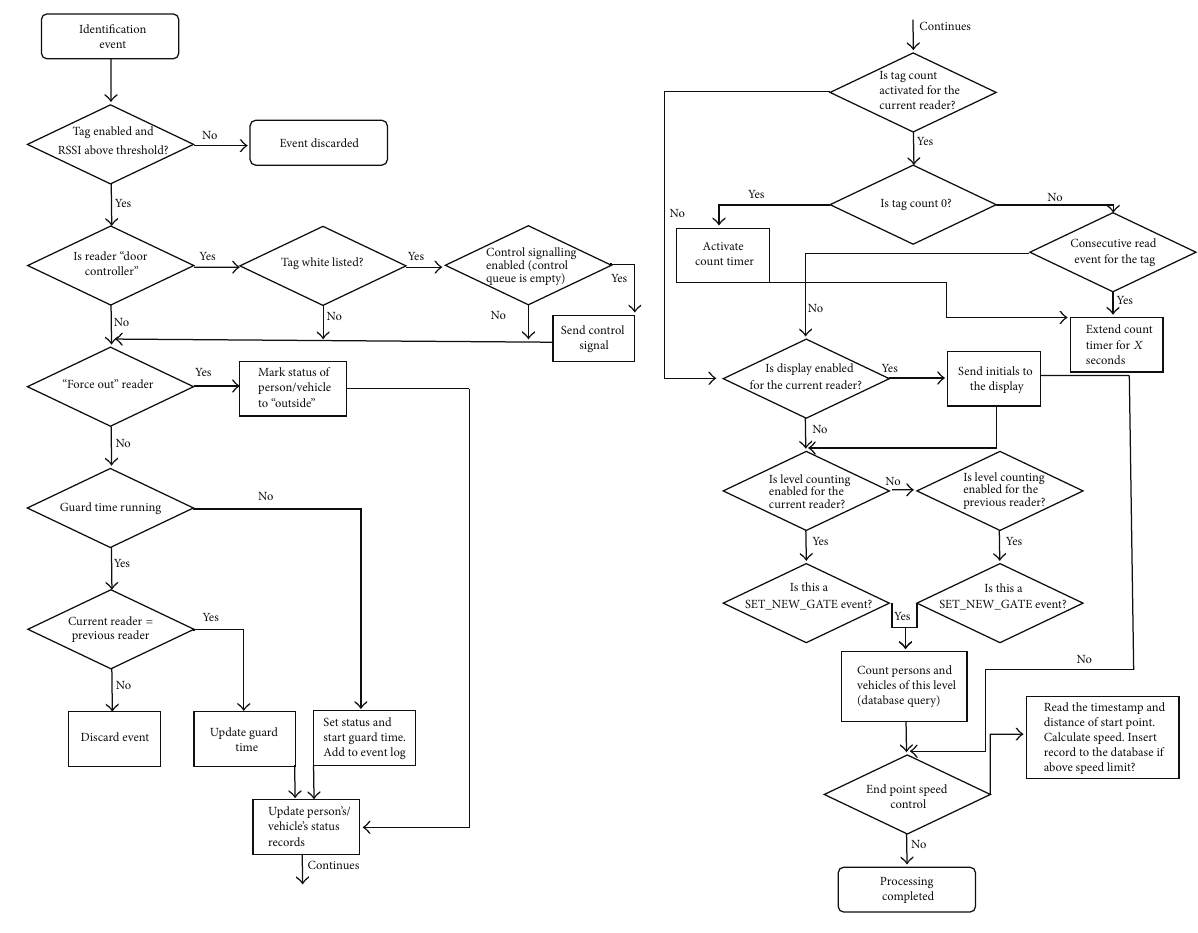
Figure 4: The reading